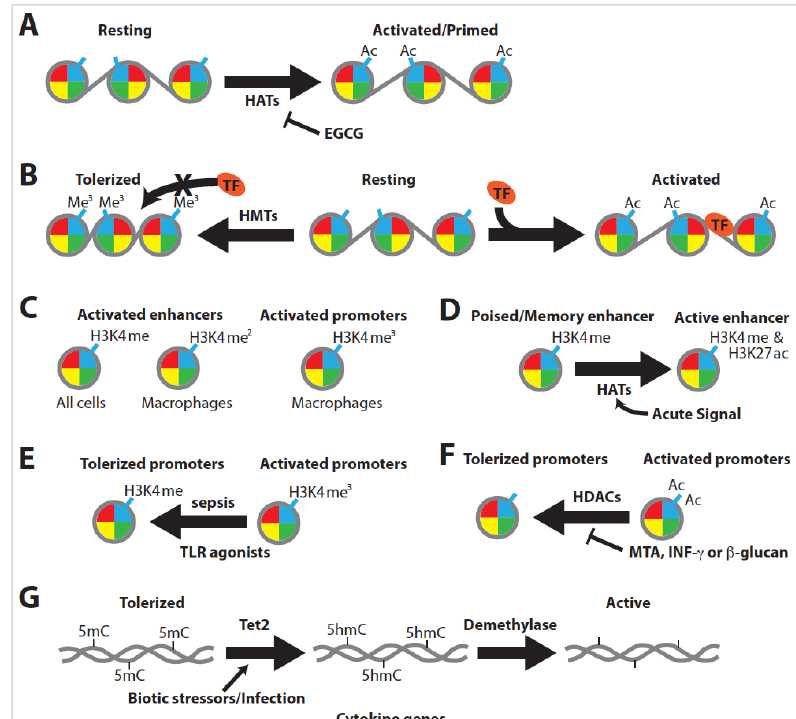
Figure 6. Chromatin can be compacted or decompacted, resulting in gene expression or repression, depending on the type of stimuli received by the cells and the resulting histone modifications or DNA methylation